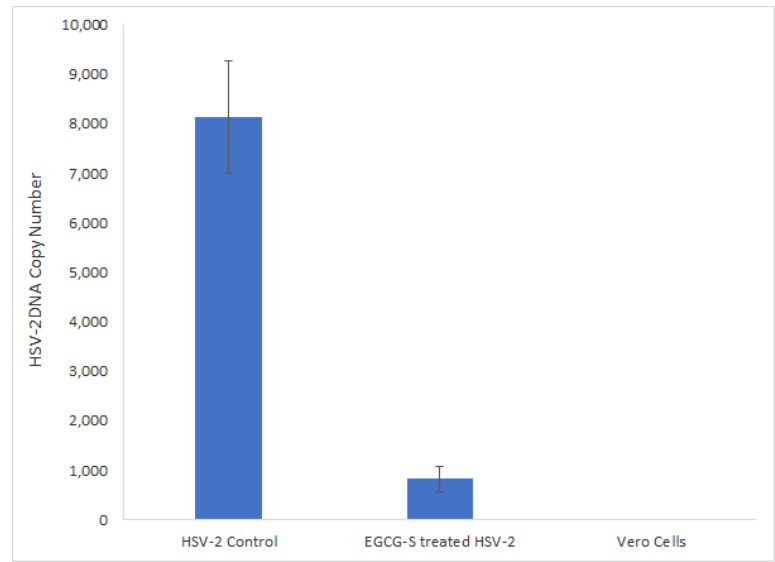
Figure 7. Real-time PCR (qPCR) analysis of HSV-2 DNA extracted from Vero cells infected with untreated HSV-2 and HSV-2 pretreated with 75 µM EGCG-S. The viral DNA copy number was determined by using a standard curve. Statistical significance was determined by using a paired Student’s t -test.